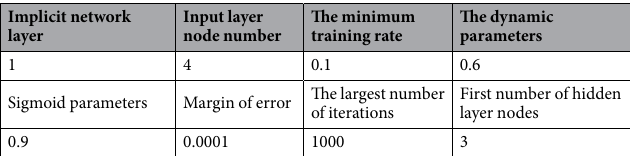
Table 5. The BPNN model parameters.